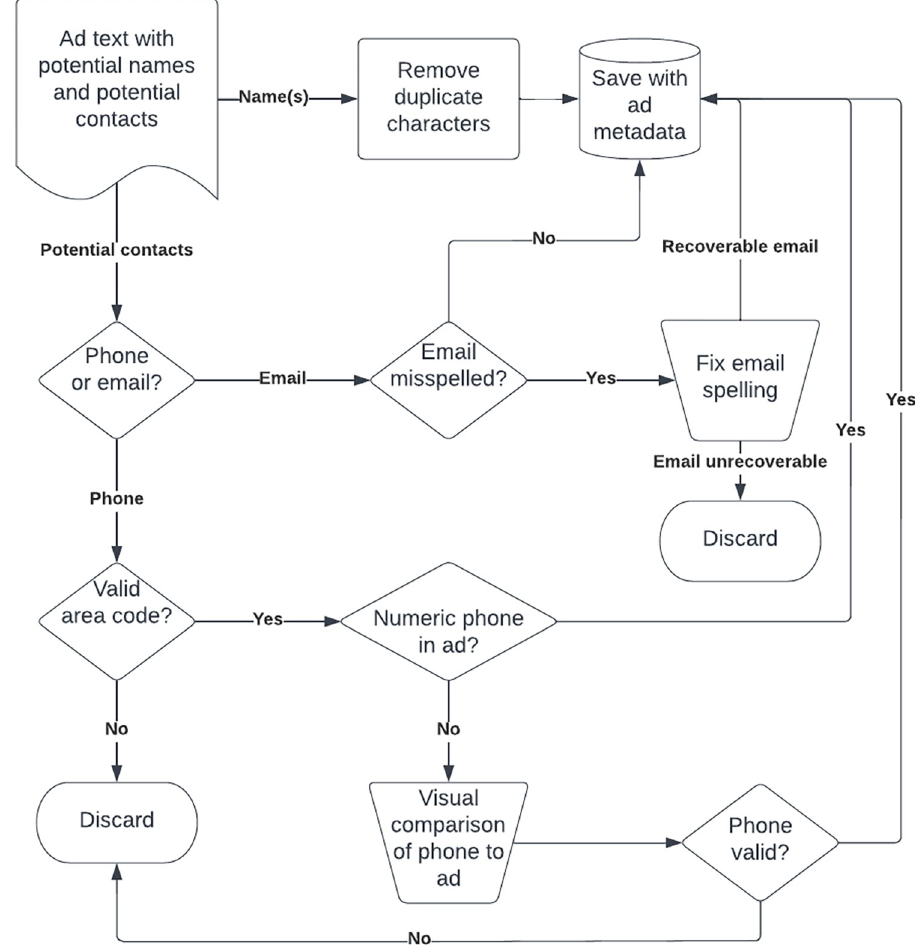
Fig 2. Contact and name processing flow diagram.